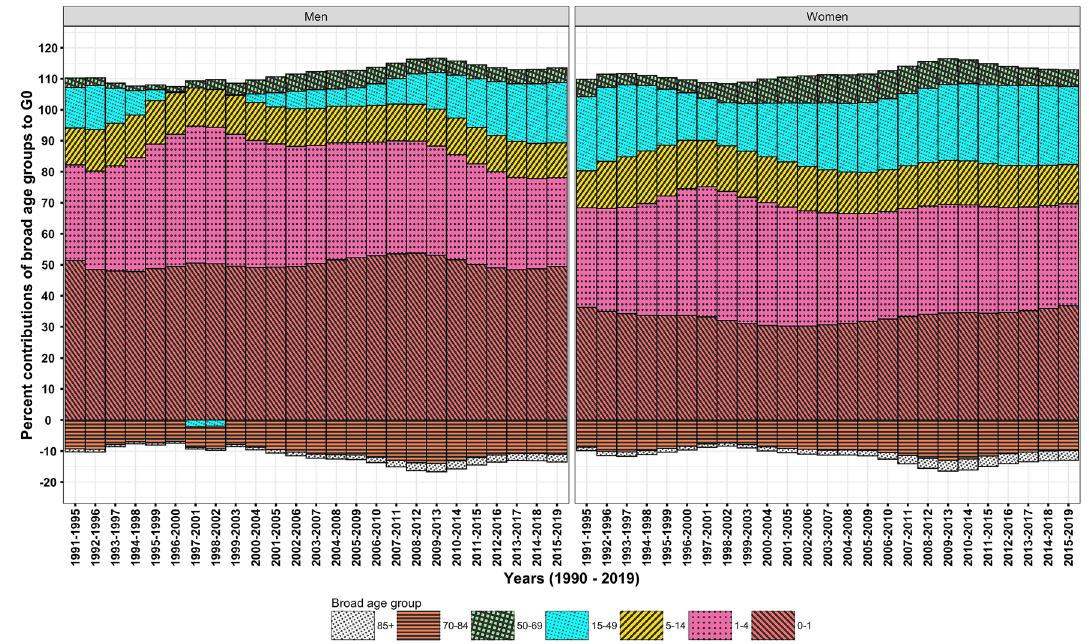
Figure 3. Temporal changes in age-specific contributions to ΔG 0 , men and women,